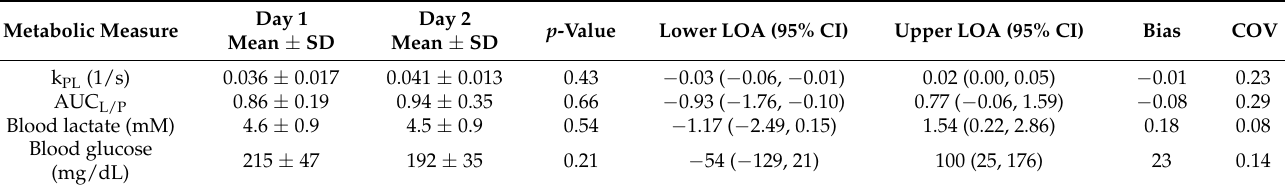
Table A1. Summary of repeated measure results for combined data from 4T07 and 4T1 tumor models. Mean values ± standard deviations (SD), paired t -test results, and Bland–Altman limits of agreement (LOA), 95% confidence intervals (CI), and bias are included. Each imaging and biochemical metric included 6 paired samples (i.e., 3, 4T1 and 3, 4T07 samples